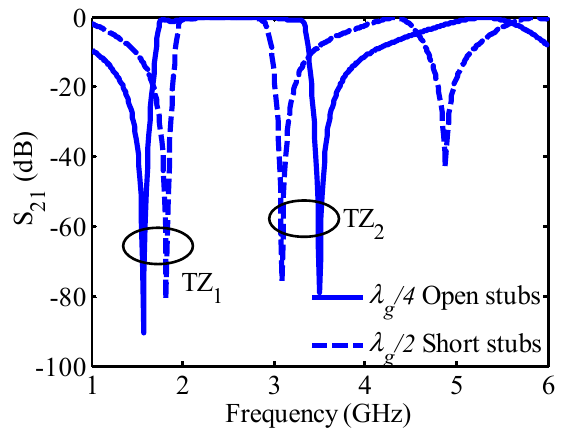
Figure 8. Simulated S 21 comparison between length λ g / 4 open-ended stubs and length λ g / 2 short-ended stubs.